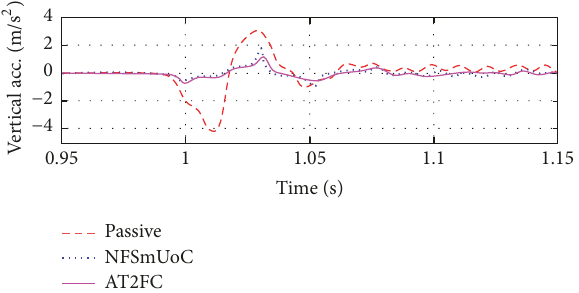
Figure 16: Vertical acceleration related to each control method.